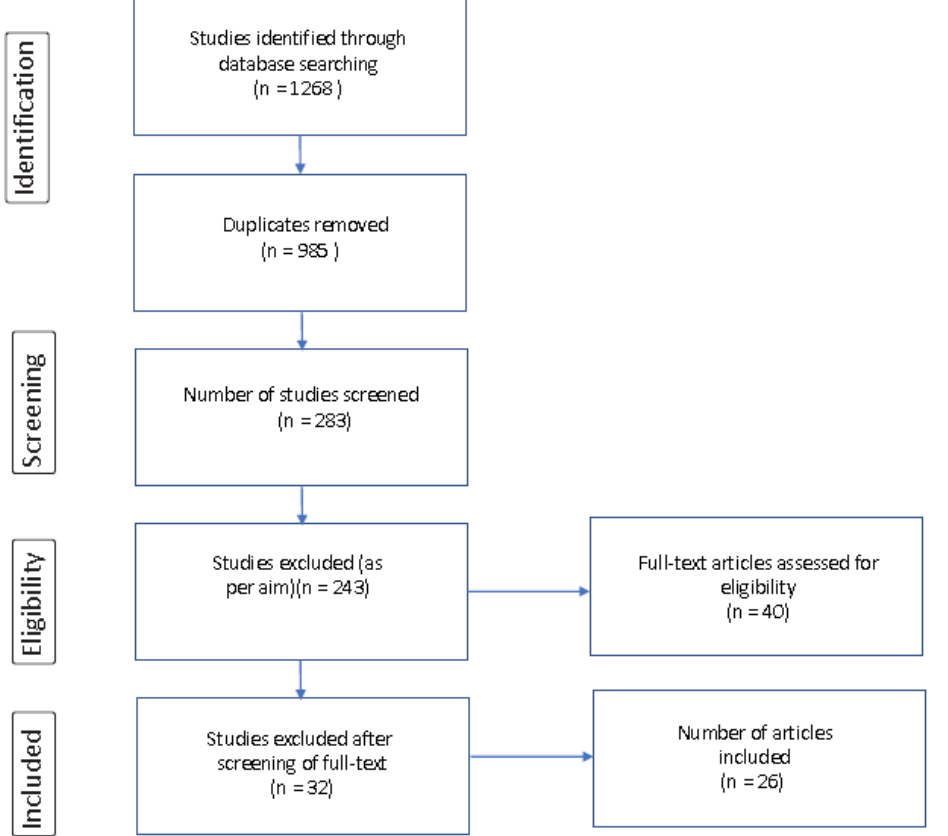
Figure 1. PRISMA flow diagram. Source: authors compilation.